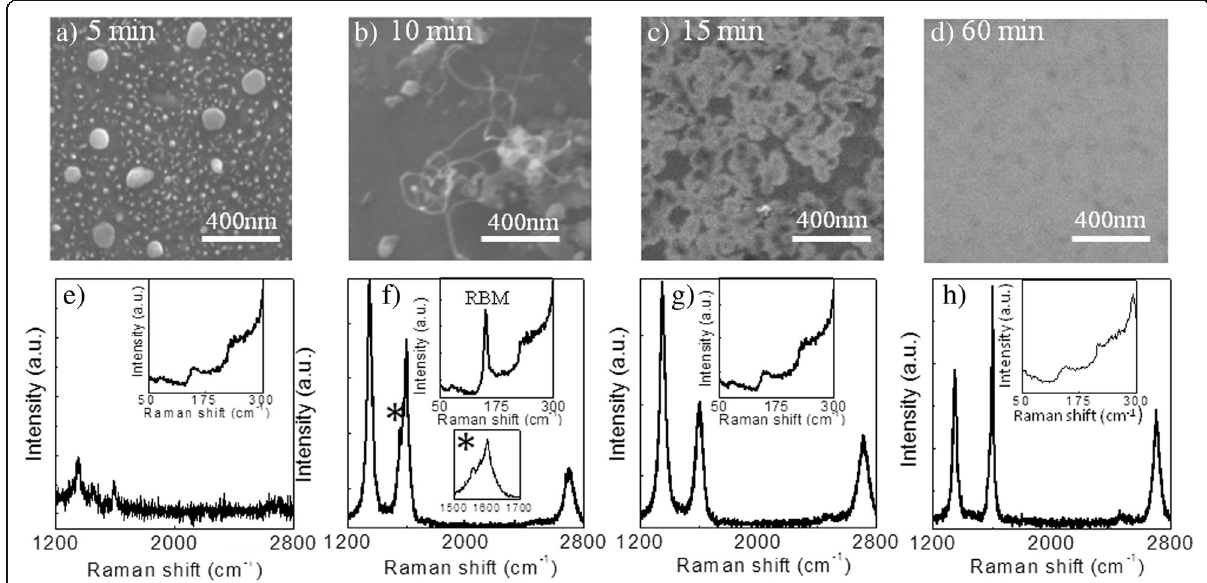
Fig. 1 SEM images of carbon-based nanostructures directly grown on silica at 1100 °C for growth time of a 5 min, b 10 min, c 15 min, and d 60 min. e – h Their respective Raman spectra in the frequency range 1200 to 2800 cm − 1 . The Raman features in the frequency range 50 – 300 cm − 1 are illustrated as insets in e – h . G band splitting in f around 1560 cm − 1 marked as asterisk and the presence of the RBM peak near 150 cm − 1 indicates the formation of